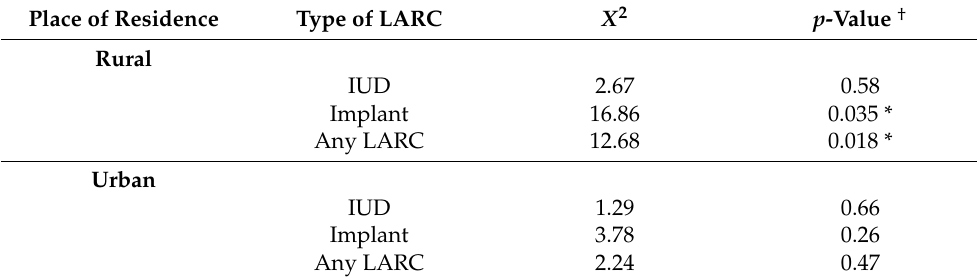
Table 2. Association between year change and rates of LARC use by place of residence. Place of Residence